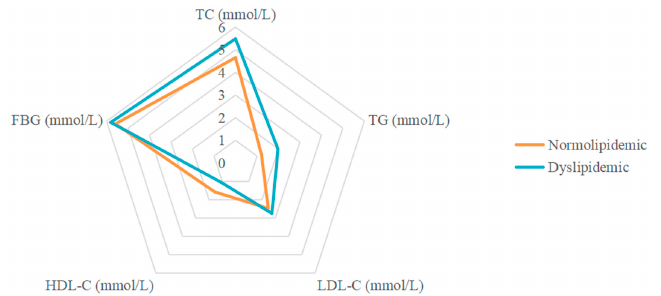
Figure 1. Radar plot of FPG and blood lipids in dyslipidemic and normolipidemic participants.